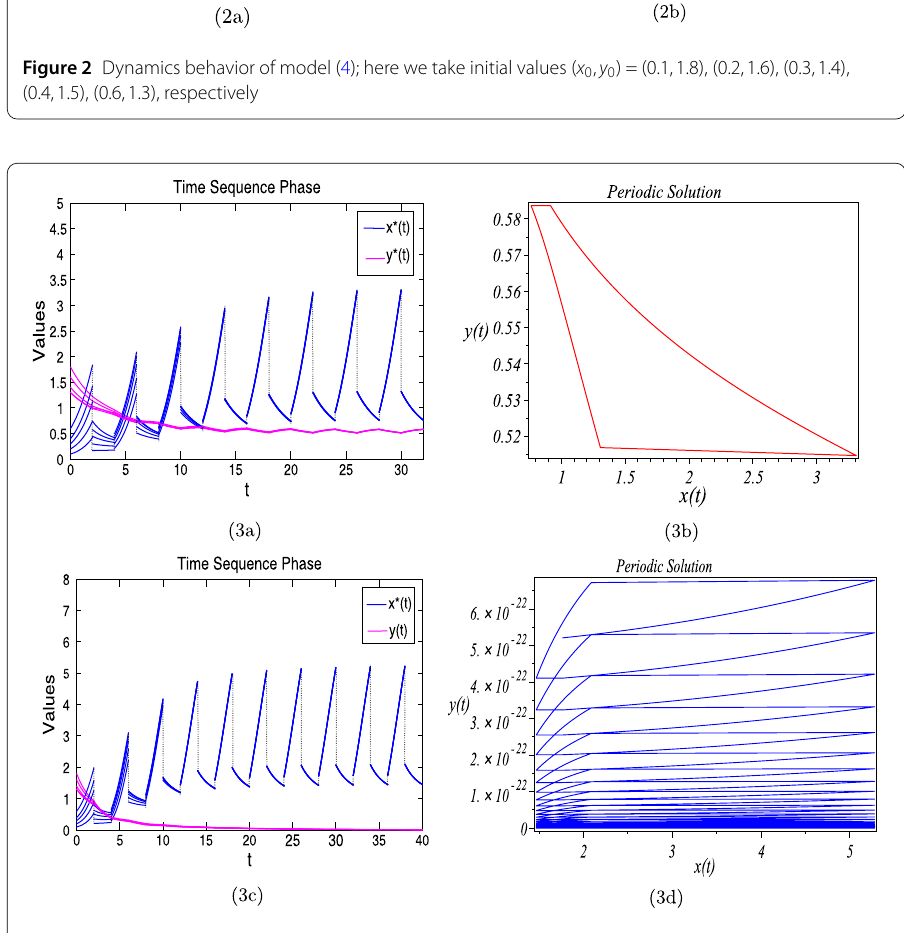
Figure 3 Dynamics behavior of model (4); here we take initial values ( x 0 , y 0 ) = (0.1,1.8), (0.2,1.6), (0.3,1.4), (0.4,1.5), (0.6,1.3), respectively